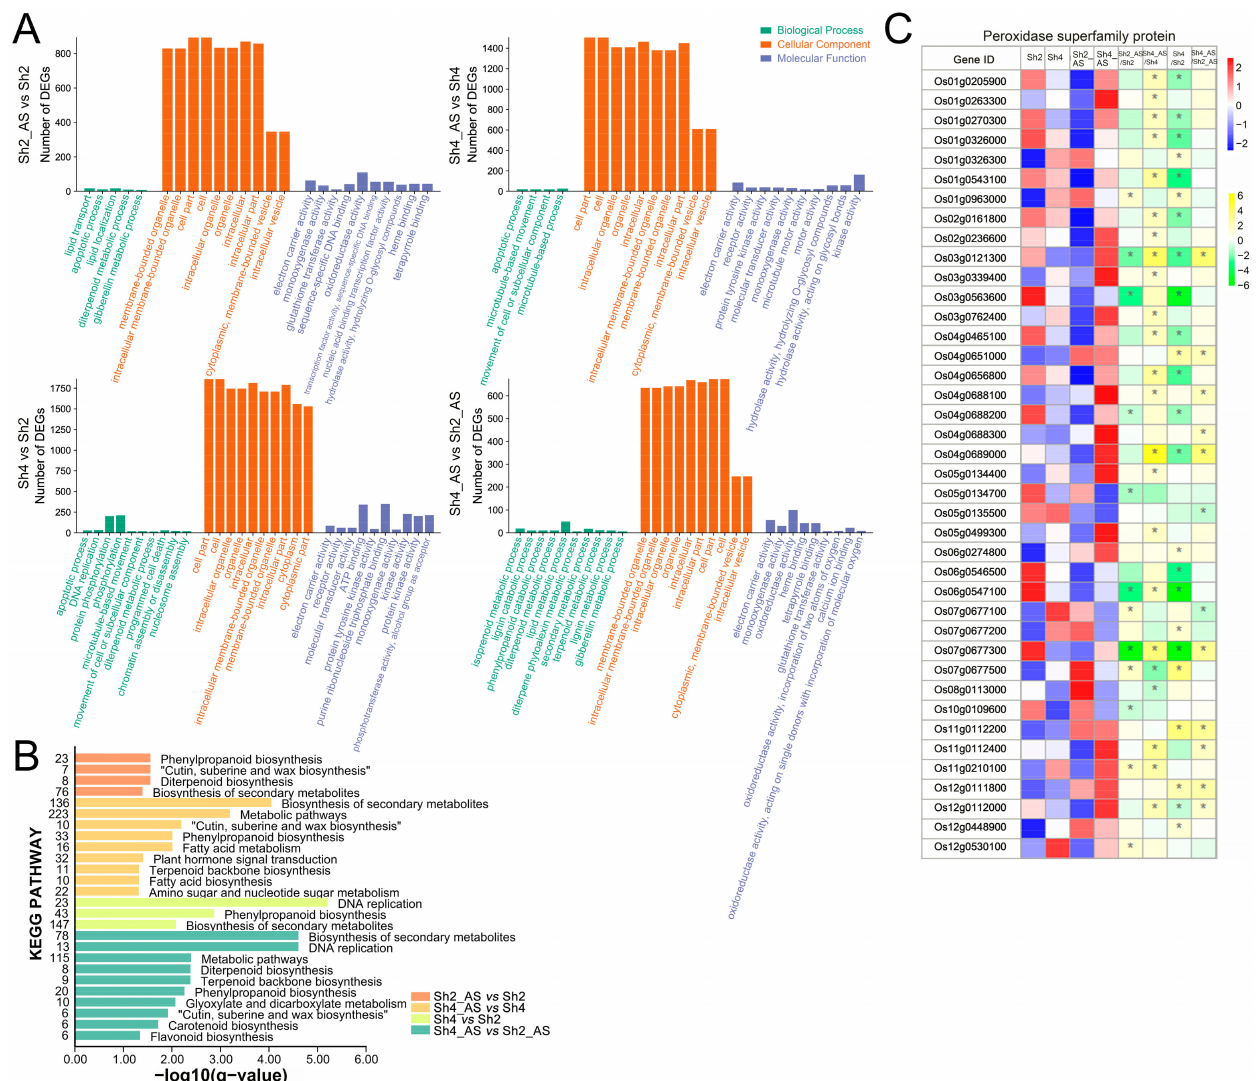
Figure 6. ( A ) Gene Ontology (GO) classification and enrichment analysis of the differentially ex- pressed genes (DEGs) in shoots between 9311-2x and 9311-4x. ( B ) Kyoto Encyclopedia of Genes and Genomes (KEGG) pathways of the significantly enriched DEGs in shoots between 9311-2x and 9311-4x. ( C ) Heatmap of the expression of genes related to peroxidase superfamily proteins in the shoots of 9311-2x and 9311-4x rice plants. Yellow indicates gene expression levels (read counts per million with log2 value). White indicates the fold change (log2 value) of DEGs. * p < 0.05. R2 and R4 represent the root samples derived from 9311-2x and 9311-4x plants, respectively. R2_AS and R4_AS represent the alkaline stress treated root samples derived from 9311-2x and 9311-4x plants, respectively. Likewise, Sh2 and Sh4 represent the shoot samples derived from 9311-2x and 9311-4x plants, respectively. Sh2_AS and Sh4_AS represent the alkaline stress treated shoot samples derived from 9311-2x and 9311-4x plants,